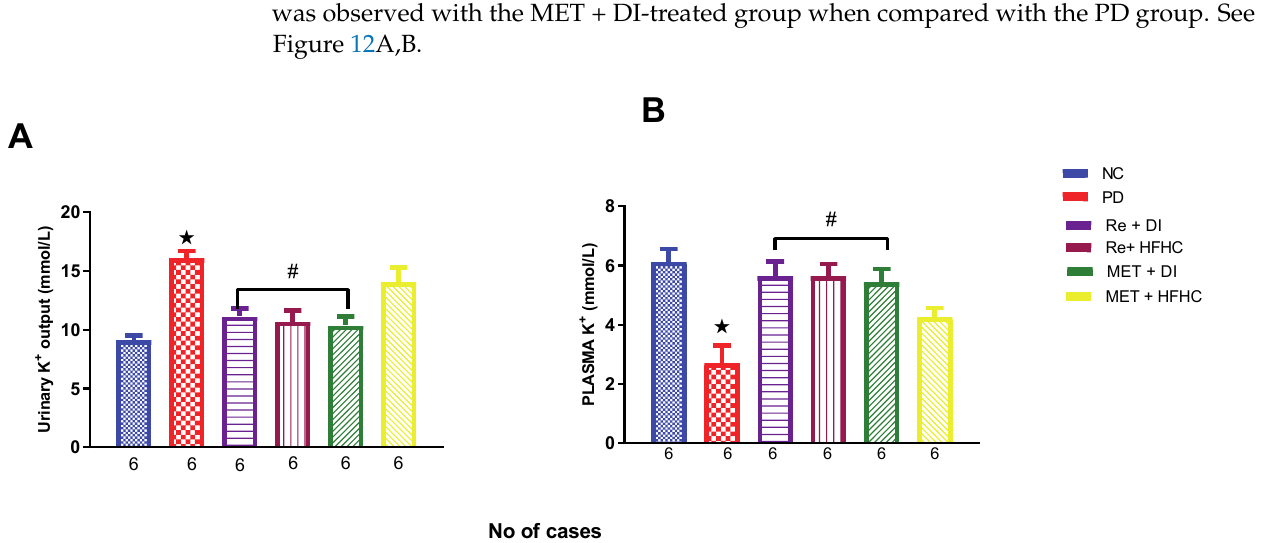
Figure 12. ( A , B ) Urinary and plasma K + concentration in normal control (NC), prediabetic control